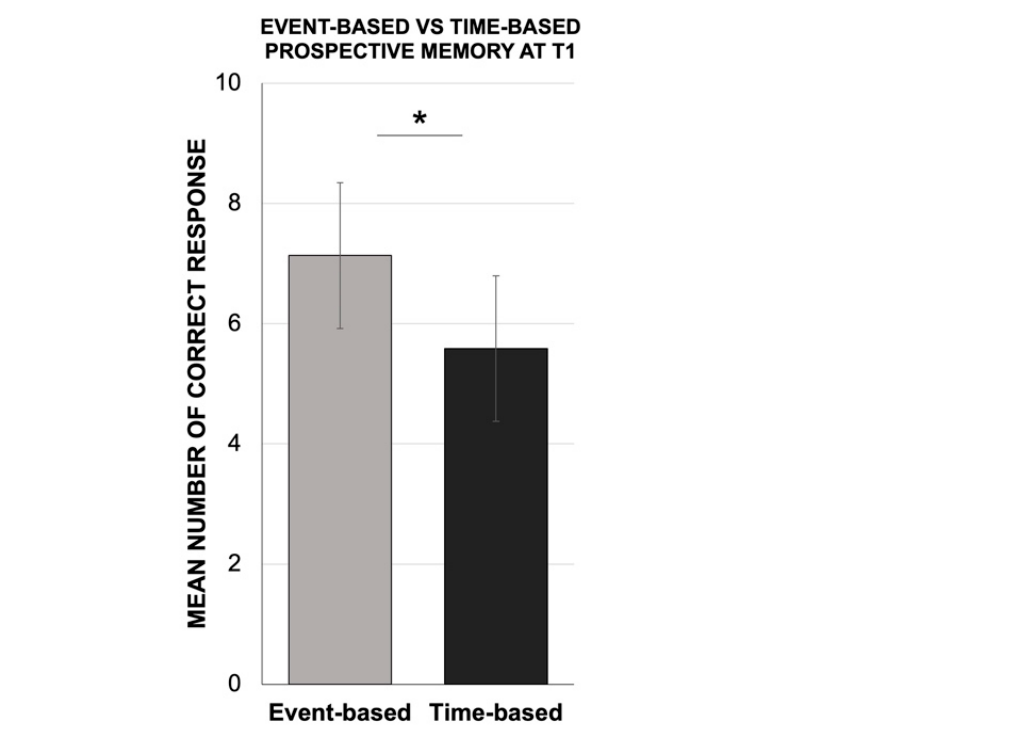
Figure 5. Mean number of correct responses for event-based and time-based tasks of the prospective memory test at T1. * p < 0.001 at T1. Table 3. Spearman’s correlation coefficients ( ρ ) and their significance levels ( p ) are reported between the anxiety levels in the DASS-21 and the PRMQ-Prospective (PM) and Retrospective Memory (RM) subtest scores.